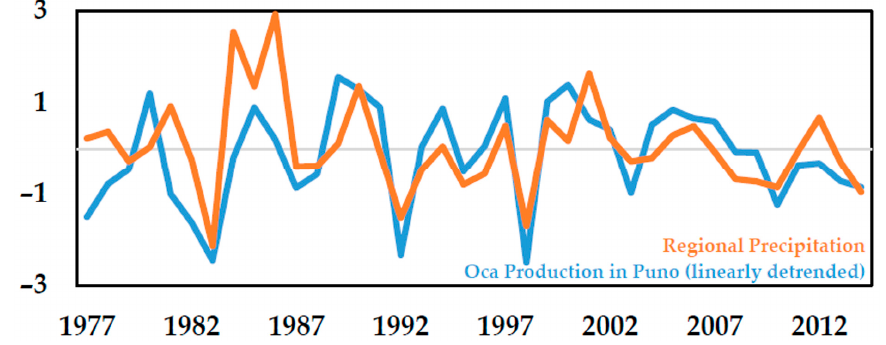
Figure 2. Normalized Puno JFM precipitation and linearly detrended annual oca yields